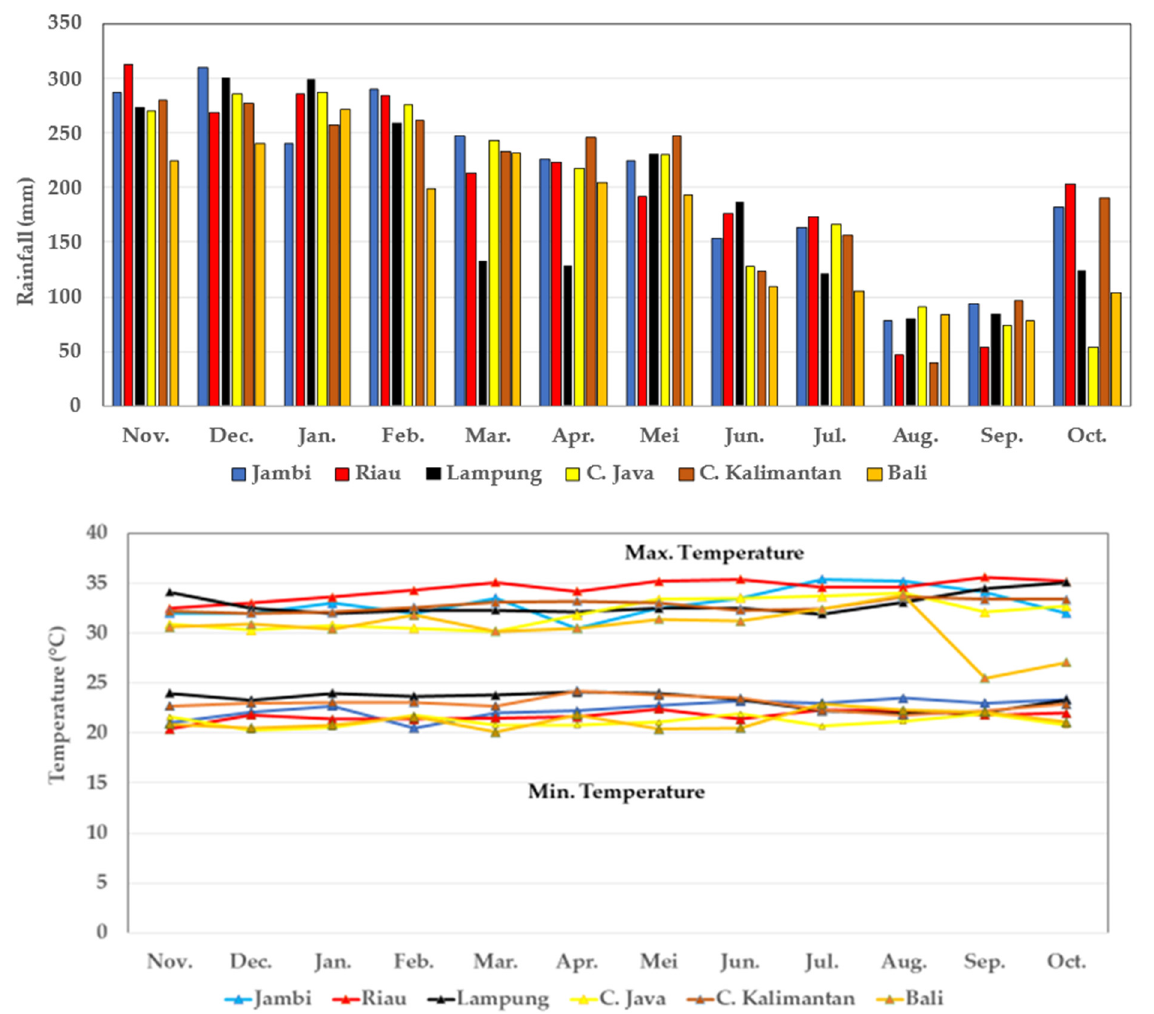
Figure 2. Average monthly rainfall, maximum and minimum temperatures for the period 2010–2019 in the study sites.